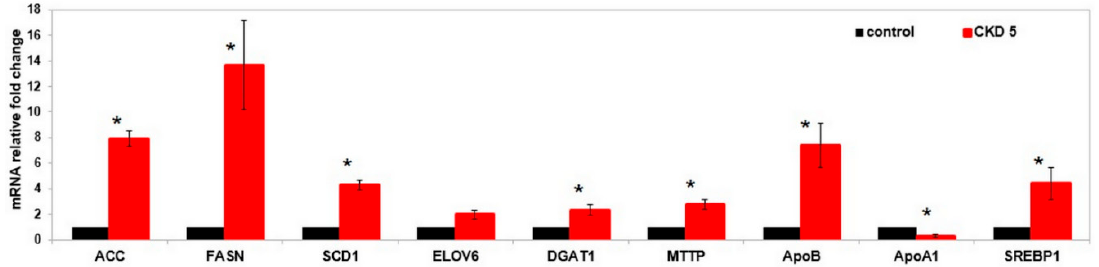
Figure 3. mRNA levels for selected genes expressed in HepG2 cells supplemented with fatty acids (FA) from control patients (control) and CKD stage 5 patients (CKD 5) serum. * p < 0.05 compared to the control. Data are presented as means ± SEM. ACC —acetyl-coenzyme A carboxylase, FASN —fatty